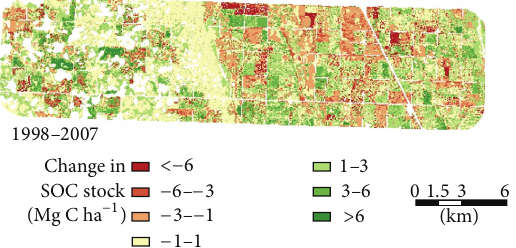
Figure 5: Spatially explicit sinks and sources of SOC in the top 20 cm depth of soil as of 2007 in comparison with the baseline in 1998. Red color represents sources and green color represents